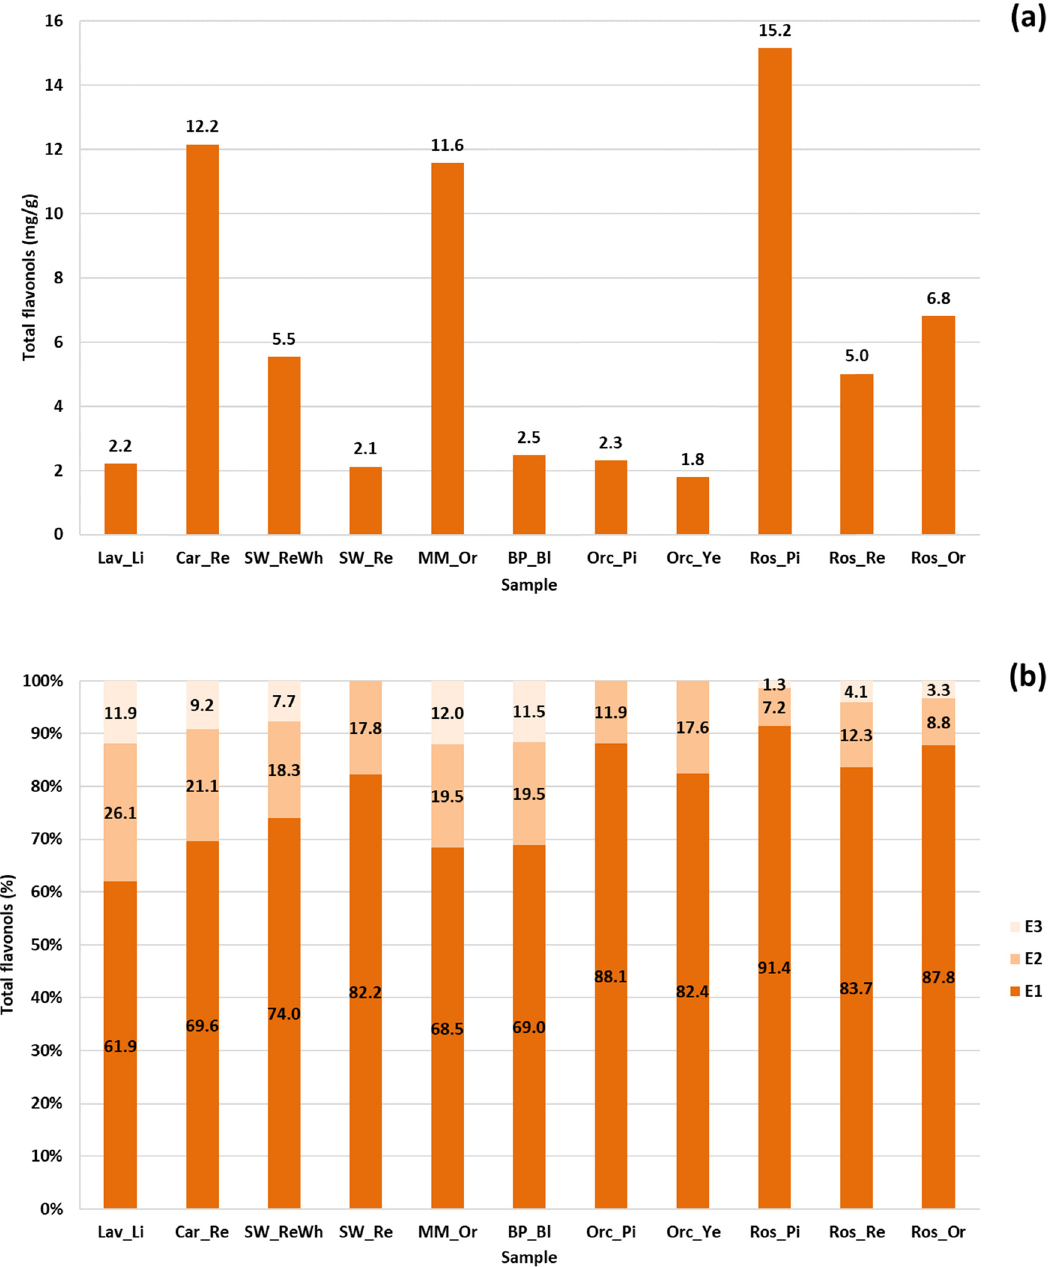
Figure 4: Total fl avonoids in the fi rst extraction ( a ) and relative percentage of three extractions ( b )